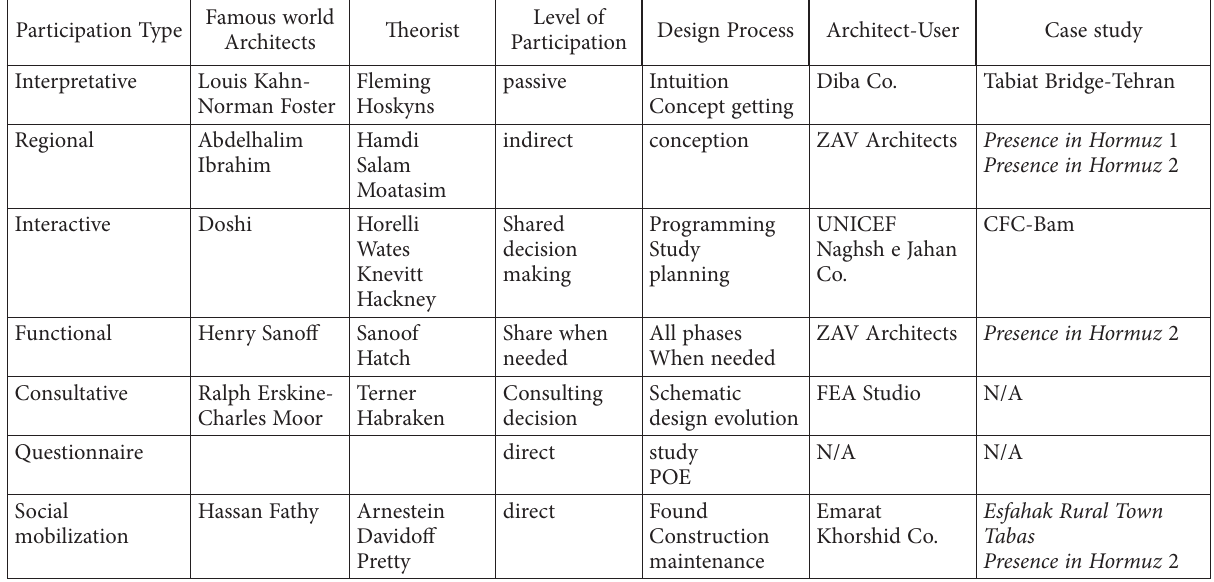
Table 10. Specific features of different typologies of participation in the design process. Contemporary Iranian Architecture (source: